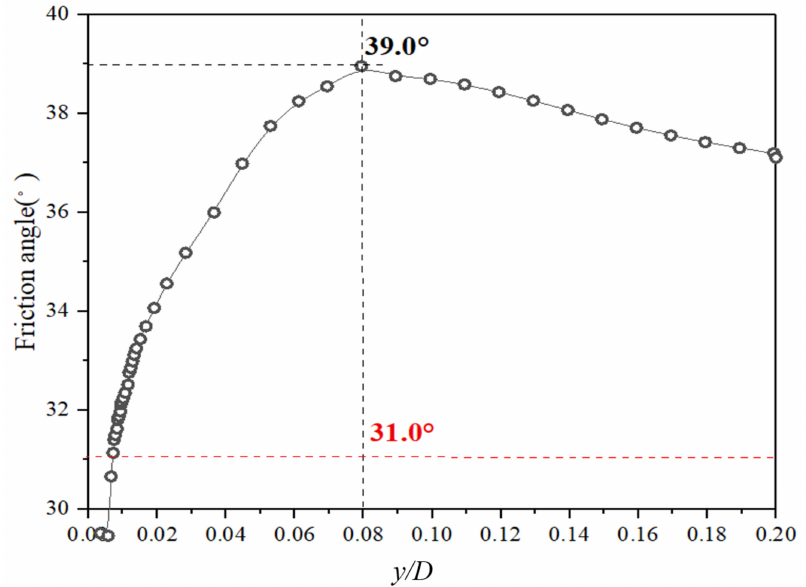
Figure 14. Evolution diagram of surface friction angle of the remaining interface after